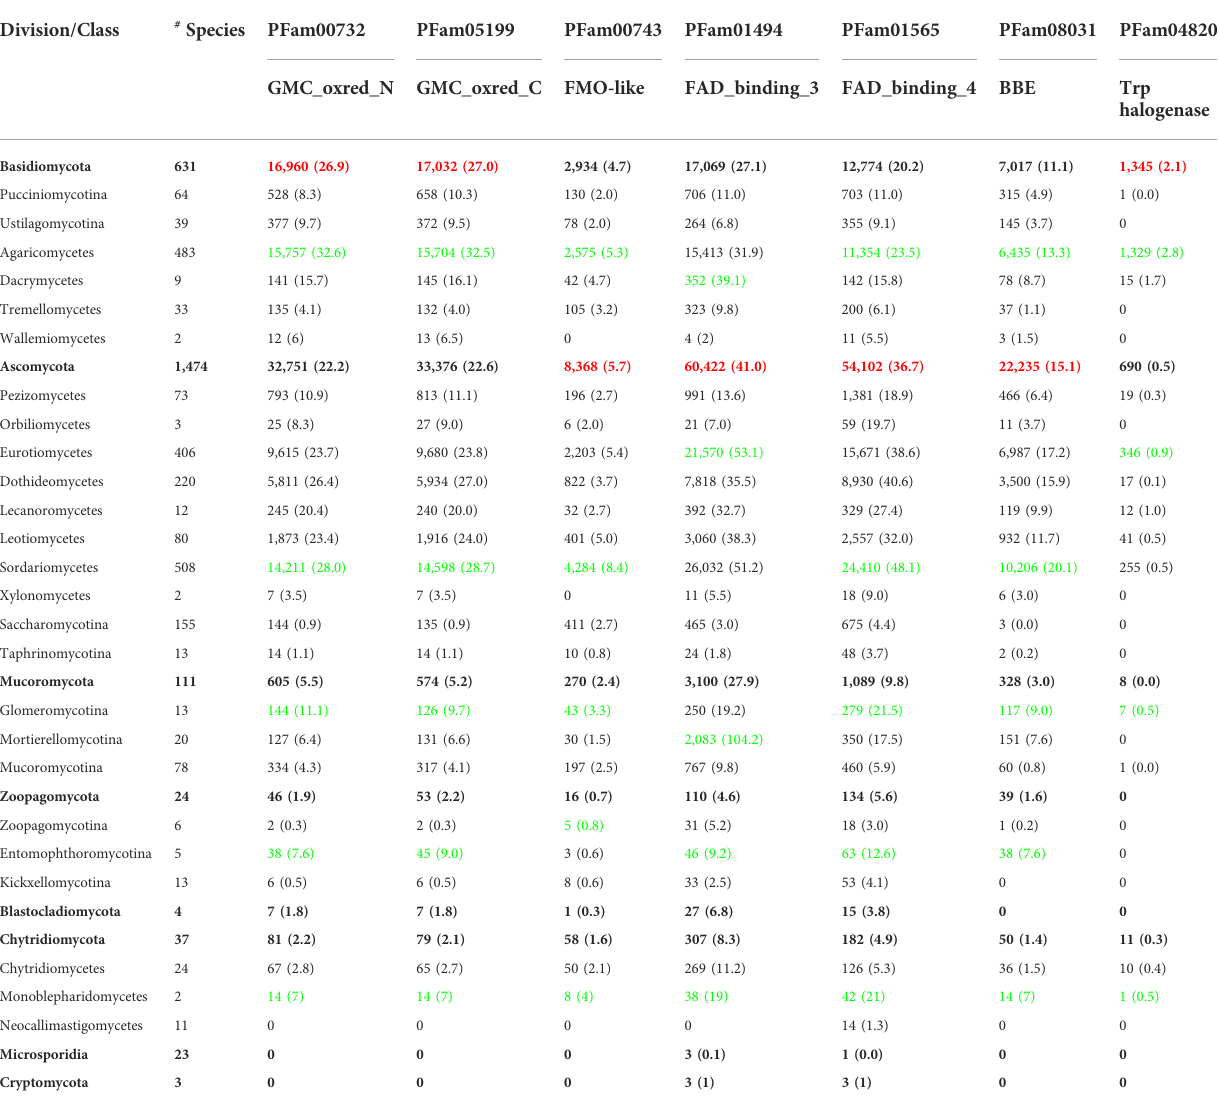
TABLE 3 Accessory fl avoproteomes in the fungal kingdom. The Table provides the total number of genes encoding for fl avin-dependent enzymes that belong to the family of GMC oxidoreductases (GMC_oxred_N and GMC_oxred_C), FMN-dependent monooxygenases (FMO-like), FAD- dependent monooxygenases (FAD_binding_3), BBE-like enzymes (FAD_binding_4 and BBE), and the FAD-dependent monooxygenases (Trp_halogenases).Thenumbersinparenthesesindicatetheaveragenumberofgenesfoundineachdivisionandclass.Thehighestaveragenumbers found in the fungal divisions are highlighted in red; the highest average numbers within a division are highlighted in green (last updated on 15 August 2022).